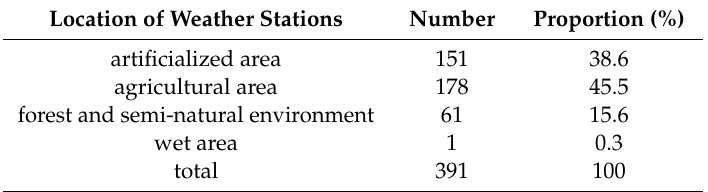
Table 1. Location of weather stations studied depending on the type of Land Use Land Cover